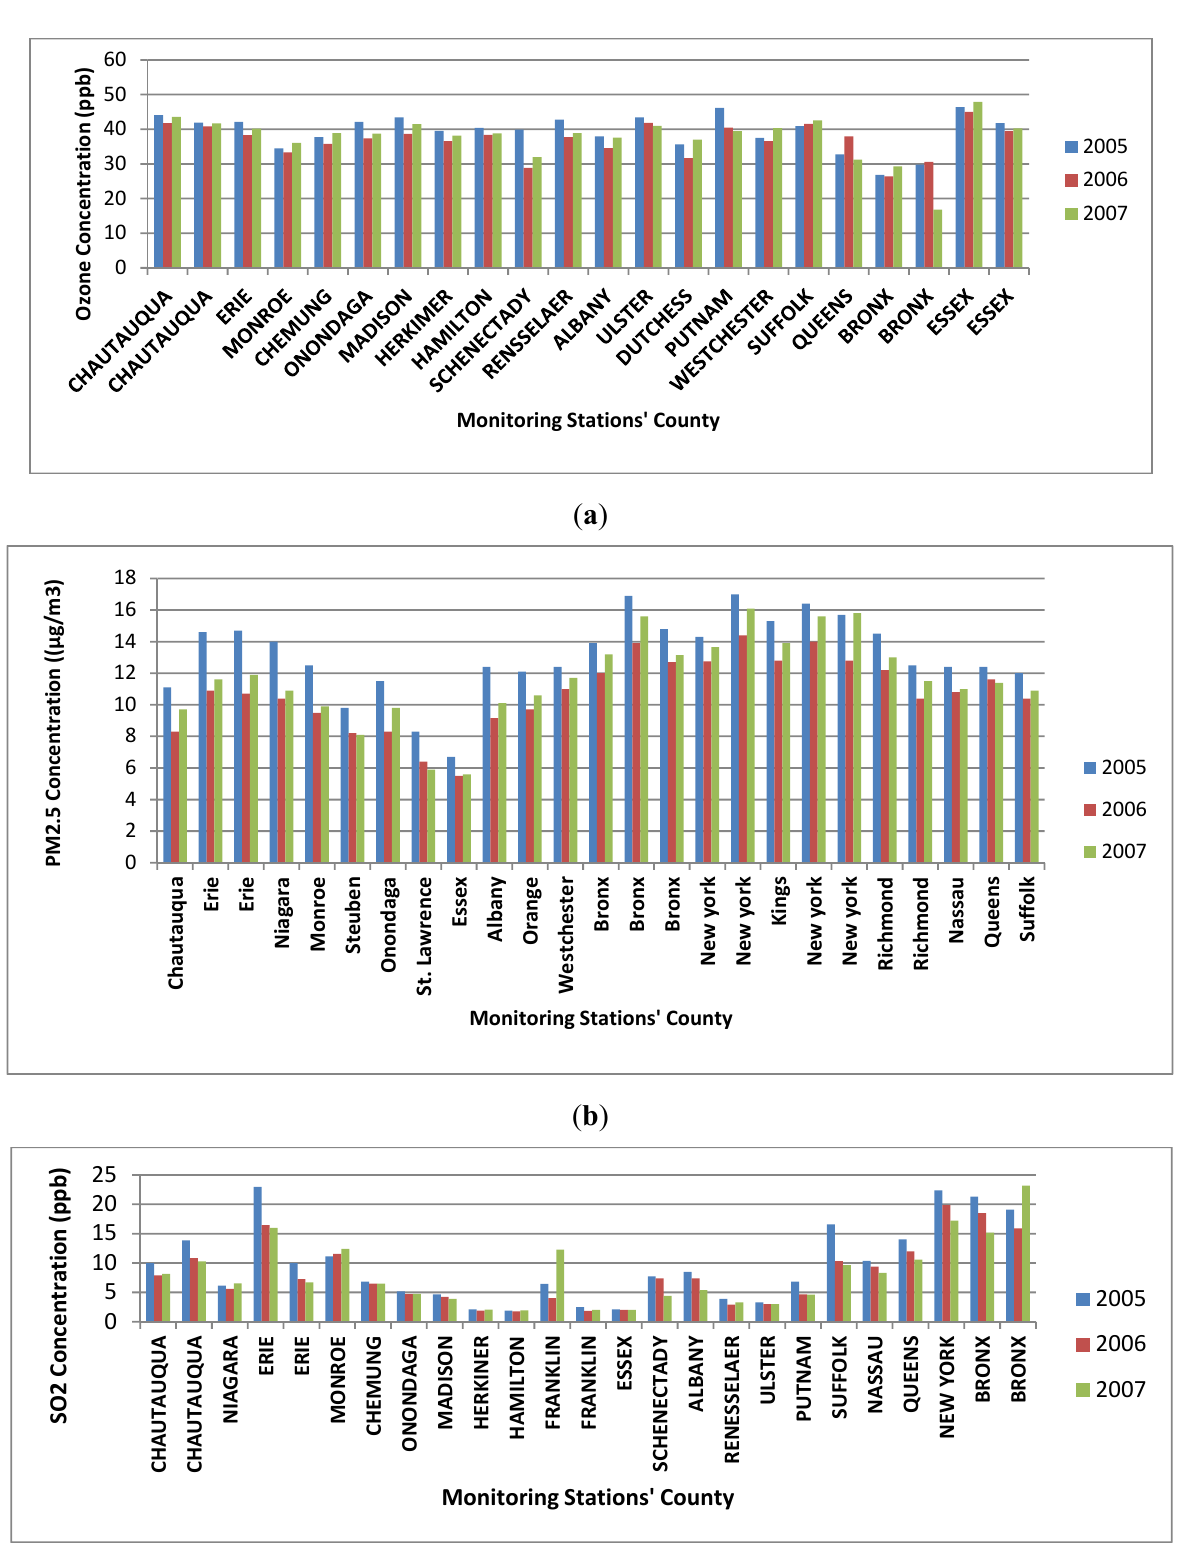
in various monitoring stations; 2.5 in various monitoring 2